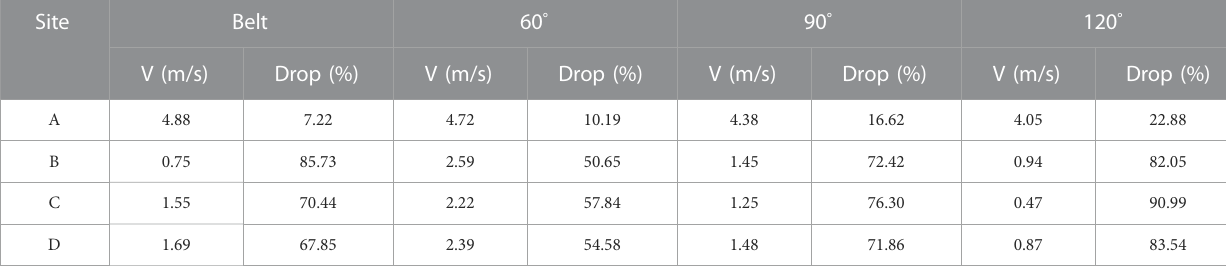
TABLE 1 Gradient table of wind speed at 0.05 m height near surface.